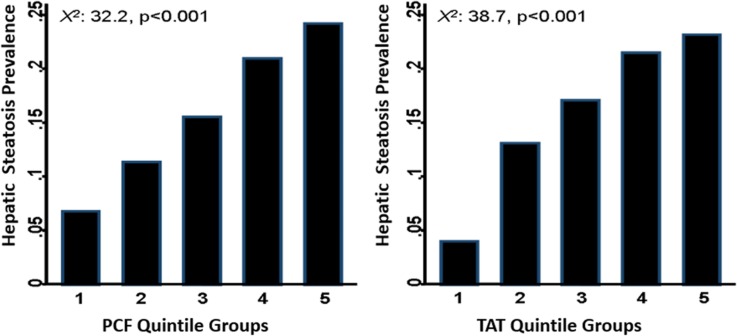
Prevalent hepatic steatosis across PCF, TAT volume quintiles.Subjects with higher quintile of PCF and TAT volume were more likely to have prevalent Hepatic Steatosis (both p<0.001 for X2 test: 32.2 & 38.7, respectively).